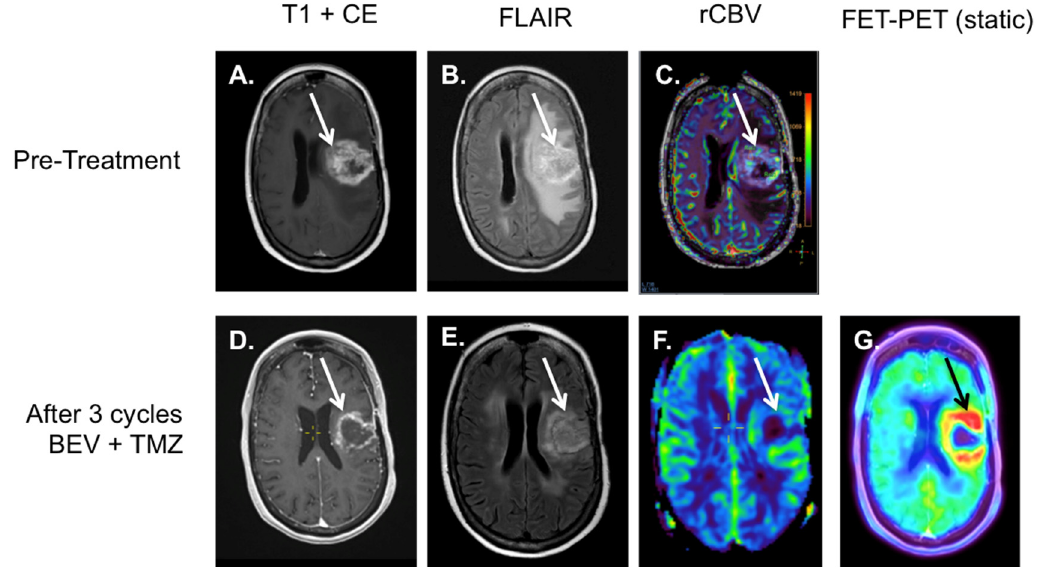
Figure 5. Patient with a GBM in the left frontal lobe that was treated with debulking and concurrent chemoradiation. Patient presented with progressive neurological decay. On the first post-treatment MRI, a persistent mass with contrast enhancement was found (white arrow image ( A )), with edema (white arrow image ( B )) and mass effect causing midline shift ( B ) and areas with increased perfusion on the rCBV at the resection margins (white arrow image ( C )). Patient was subsequently treated with 3 cycles of BEV and temozolomide, with a clear decrease in contrast enhancement on MRI (white arrow, image ( D )), and a decrease in mass effects, edema, and gliosis (white arrow image ( E )). Perfusion did not show any areas with persistent increased perfusion on the rCBV map (white arrow image ( F )). However, the 18 F-FET-PET did show a diffuse elevated tracer accumulation at the height of the resection margins (black arrow image ( G )), illustrative of